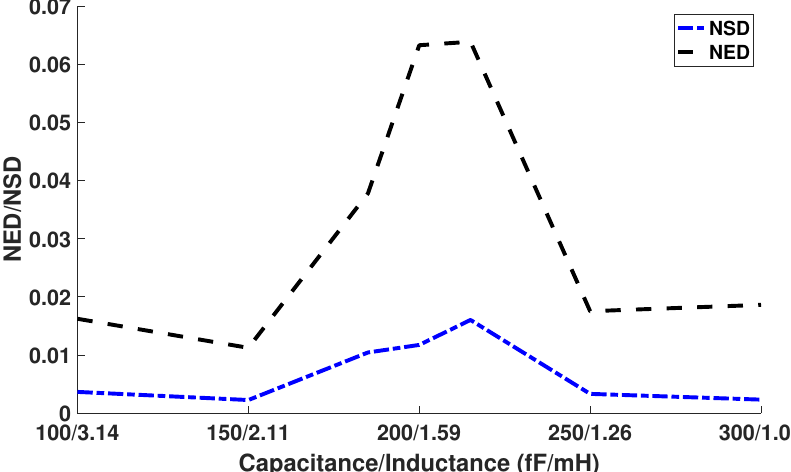
Figure 16. Effect of changing capacitor and inductor on NED and